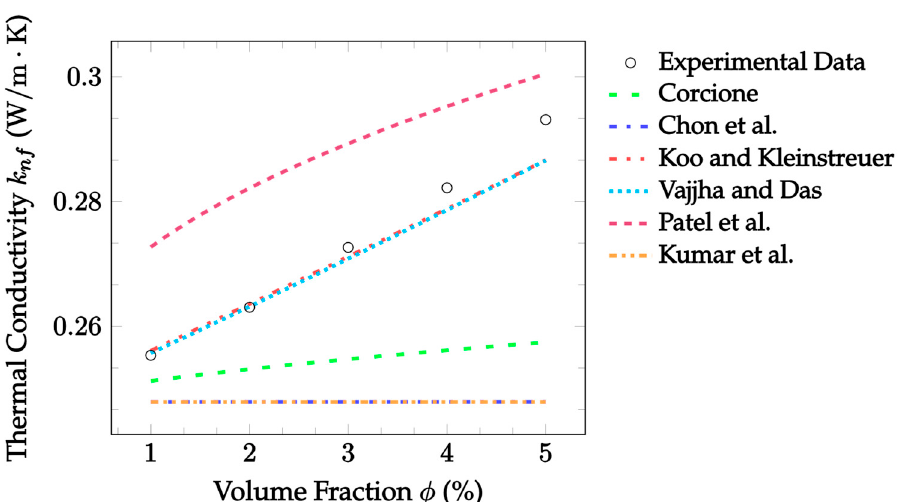
Figure 3. Brownian model predictions compared with experimental data for Al 2 O 3 –EG nanofluid at 300 K, with a particle diameter of 24.4 nm and volume fractions from 1% to 5%: Experimental Data [12], Corcione [19], Chon et al. [20], Koo and Kleinstreuer [21], Vajjha and Das [22], Patel et al. [23], Kumar et al. [24].